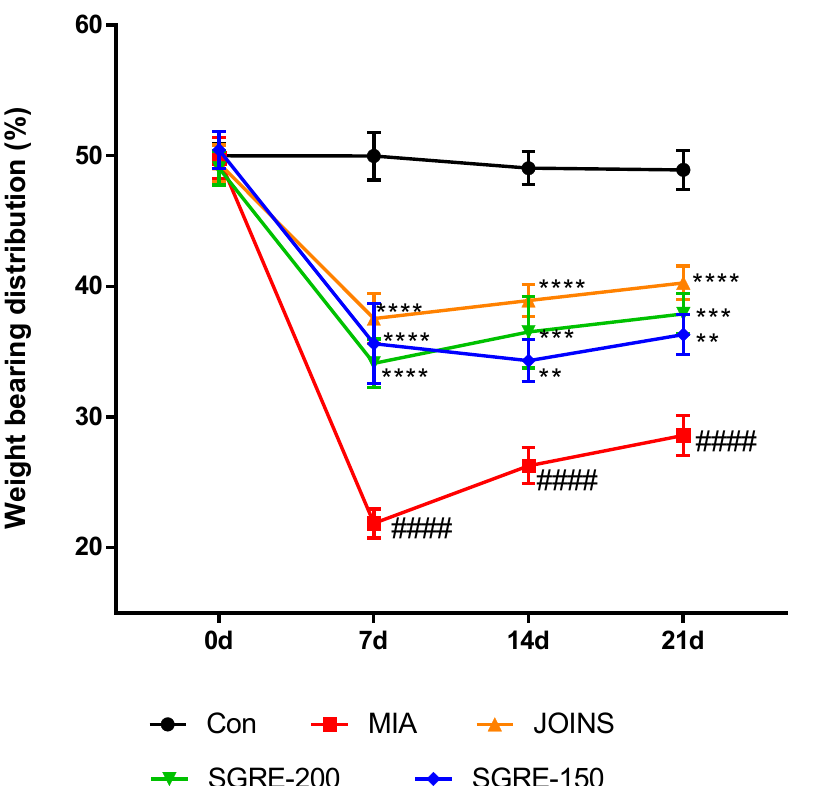
Figure 6. Effects of SGRE on the changes in hind paw weight-bearing distribution in MIA-induced OA rats. The results of the SGRE-treated groups were compared with those of the MIA-induced group. n = 7 per group. #### p < 0.0001 vs. control group. ** p < 0.01; *** p < 0.001; **** p < 0.0001 vs. MIA-induced group.